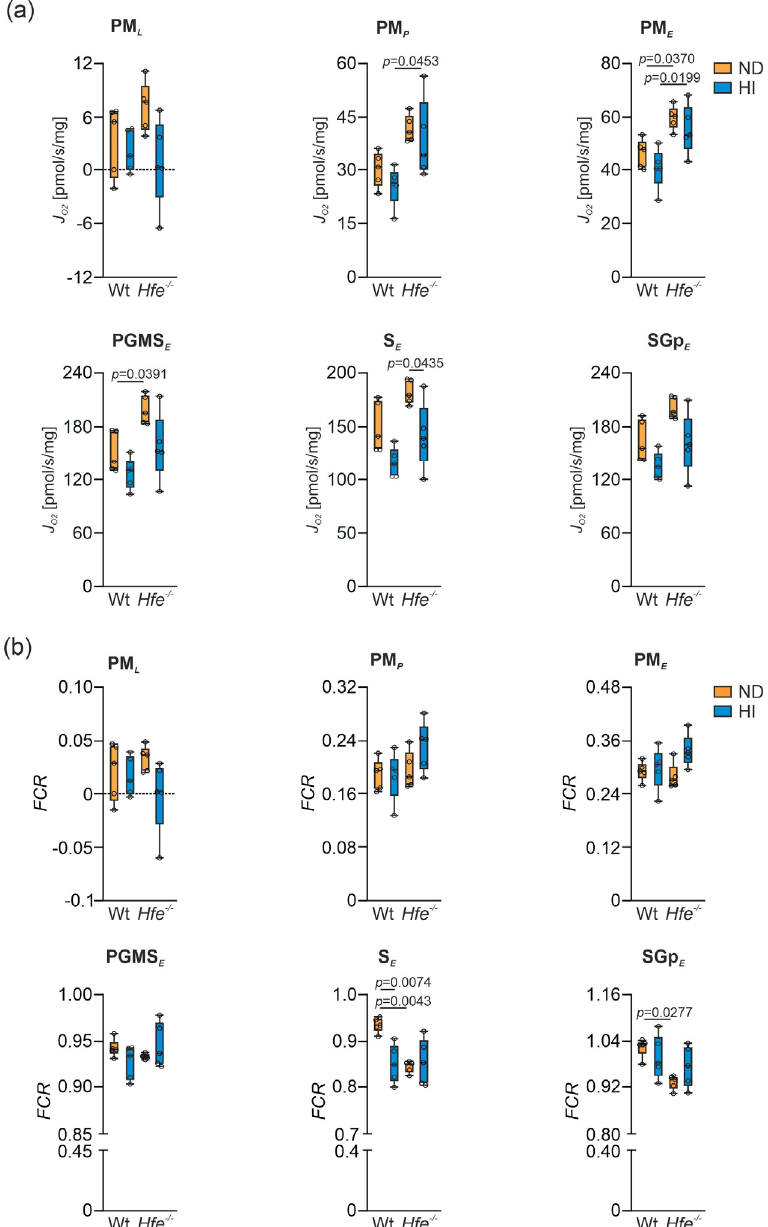
Figure 4. Effect of dietary and genetic iron overload on mitochondrial respiration in mouse liver. ( a ) Mitochondrial respiratory capacity in states PM L , PM P , PM E , PGMS E , S E and SGp E measured in homogenates from freshly isolated liver. PM L , non-phosphorylating LEAK respiration after addition of pyruvate and malate as NADH-(N) linked substrates; PM P , OXPHOS capacity upon addition of adenosine diphosphate (ADP) at kinetically saturating concentration; PM E , titrations of the protonophore carbonyl cyanide m-chloro phenyl hydrazine to reach the maximal respiration as a measure of electron transfer (ET) capacity; PGMS E , addition of succinate (S) provides the simultaneous action of N-linked substrates and S with convergent electron flow in the NS-pathway for reconstitution of tricarboxylic acid cycle function; S E , Complex I inhibition by rotenone for measurement of S-linked ET capacity; SGp E , titration of glycerophosphate (Gp) provided simultaneous action of S-linked substrate succinate and Gp with convergent electron flow in the SGp-pathway. ( b ) Flux control ratios (FCR) for PM L , PM P , PM E , PGMS E , S E and SGp E shown in ( a ); OctPGMS E served as common reference state. n = 5 mice per group. Two-way ANOVA: ( a ) PM L —diet, F (1,16) = 5.109, p = 0.0381; genotype, F (1,16) = 0.6326, p = 0.4380; diet X genotype, F (1,16) = 2.315, p = 0.1476; PM P —diet, F (1,16) = 1.595, p = 0.2247; genotype, F (1,16) = 15.26, p = 0.0013; diet X genotype, F (1,16) = 0.04508, p = 0.8345; PM E —diet, F (1,16) = 2.602, p = 0.1263; genotype, F (1,16) = 20.14, p = 0.0004; diet X genotype, F (1,16) = 0.04877, p = 0.8280; PGMS E —diet, F (1,16) = 8.285, p = 0.0109; genotype, F (1,16) = 12.05, p = 0.0032; diet X genotype, F (1,16) =